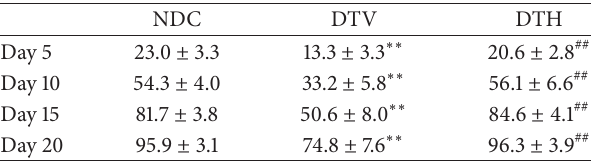
Table 1: Effects of HO-1 on closure rate of wound.